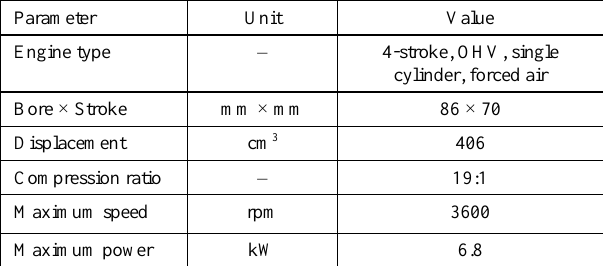
Table 2. Lifan C186F important